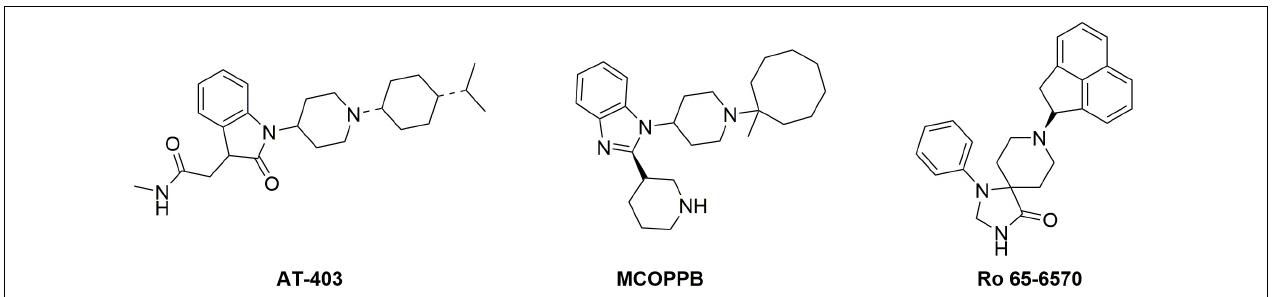
FIGURE 1 | Chemical structure of the NOP agonists used in this